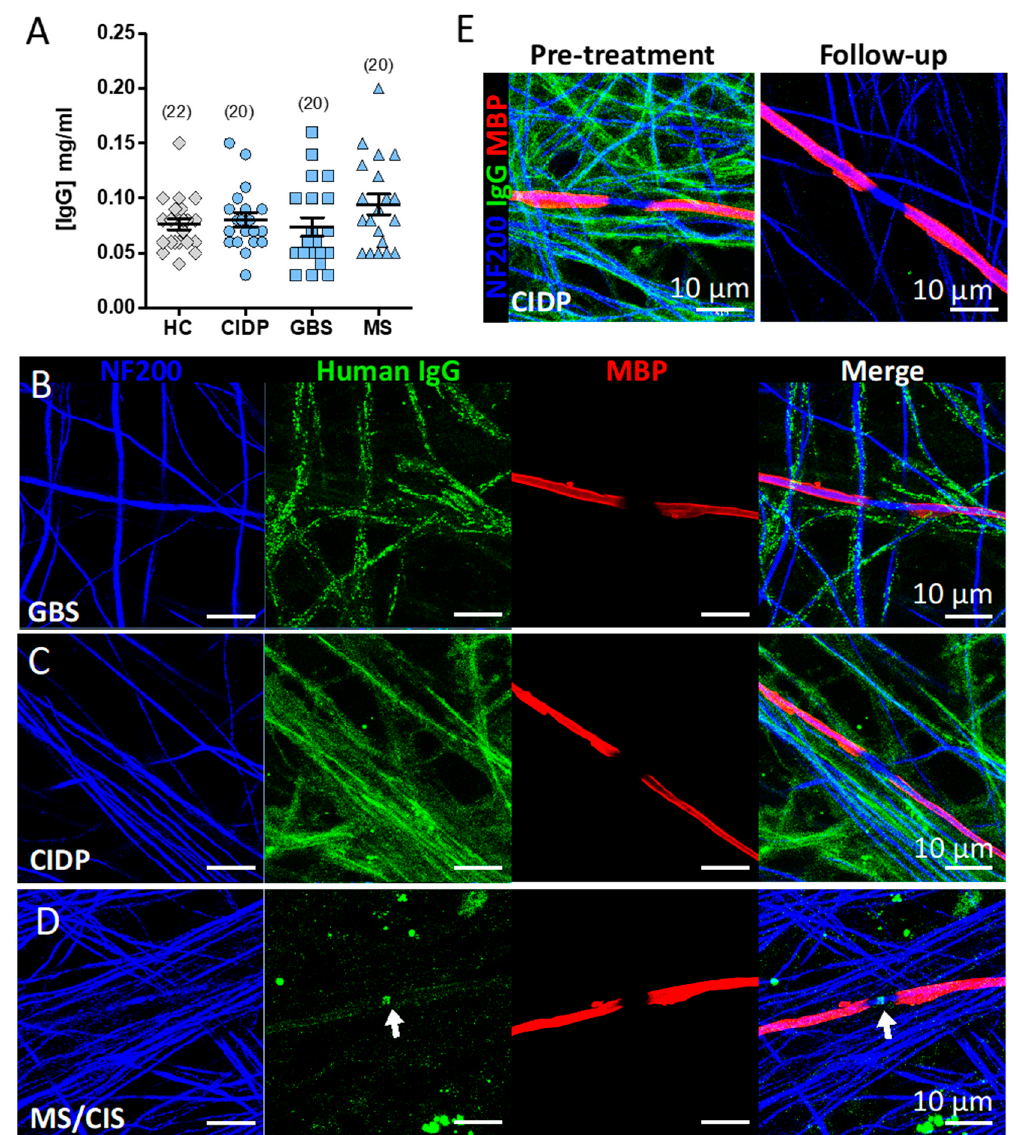
Figure 5. IgG deposition in myelinated co-cultures. ( A ) IgG concentration of dilution-adjusted eluates used for screening on myelinated cultures. ( B – D ) Immunofluorescence images of IgG binding patterns in myelinating co-cultures of IA eluates (1:50) from three patients with neurological disease identified in the screening assay: B) GBS (patient 07), C) CIDP (patient 11), and D) MS / CIS (patient 13) (arrow indicates IgG deposition at the node of Ranvier). ( E ) IgG labelling in myelinated co-cultures of serum (1:50) sampled from the CIDP (patient 11) before (Pre-treatment) and after IA (Follow-up). Note all IgG immunoreactivity is lost at follow-up. NF200, neurofilament 200; MBP, myelin basic protein.